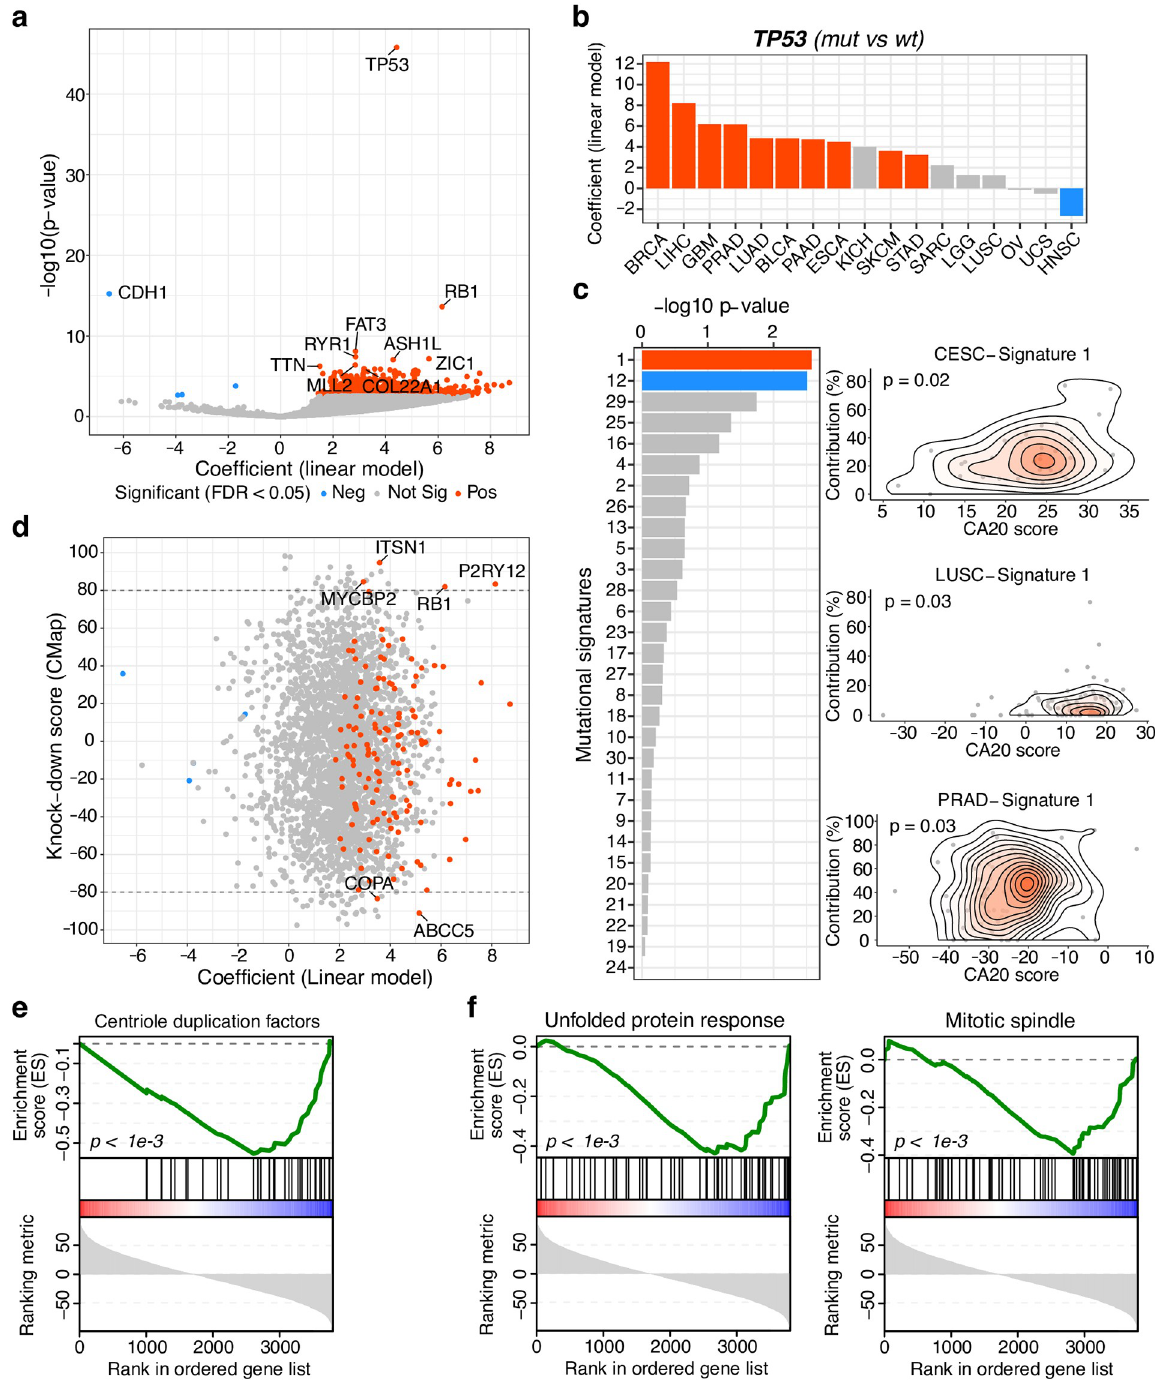
Fig 4. CA20 is associated with cancer’s mutational spectrum. ( a ) Somatic mutations pan-cancer-wide associated with the CA20 score. The volcano plot shows the results of linear regression analyses comparing the CA20 score between mutated and wild-type samples for 14,589 genes (at least 20 mutated samples). Genes whose mutations are associated with higher and lower CA20 (FDR < 0.05) are represented in red and blue, respectively. The top 10 genes are highlighted. ( b ) TP53 mutations are associated with CA20 in different cancer types. Linear regression coefficients, representing CA20 score differences between TP53 mutated and wild-type tumour samples, across TCGA cohorts with at least 20 mutated samples. Significant associations (FDR < 0.05) are coloured as in (a). ( c ) Mutational signatures pan-cancer-wide associated with CA20, independently of other types of genomic instability. Left: Significance of linear regression analyses (-log10 p-value) between CA20 and contribution of each mutational signatures including, as independent variables, the four genomic instability features: aneuploidy, mutation